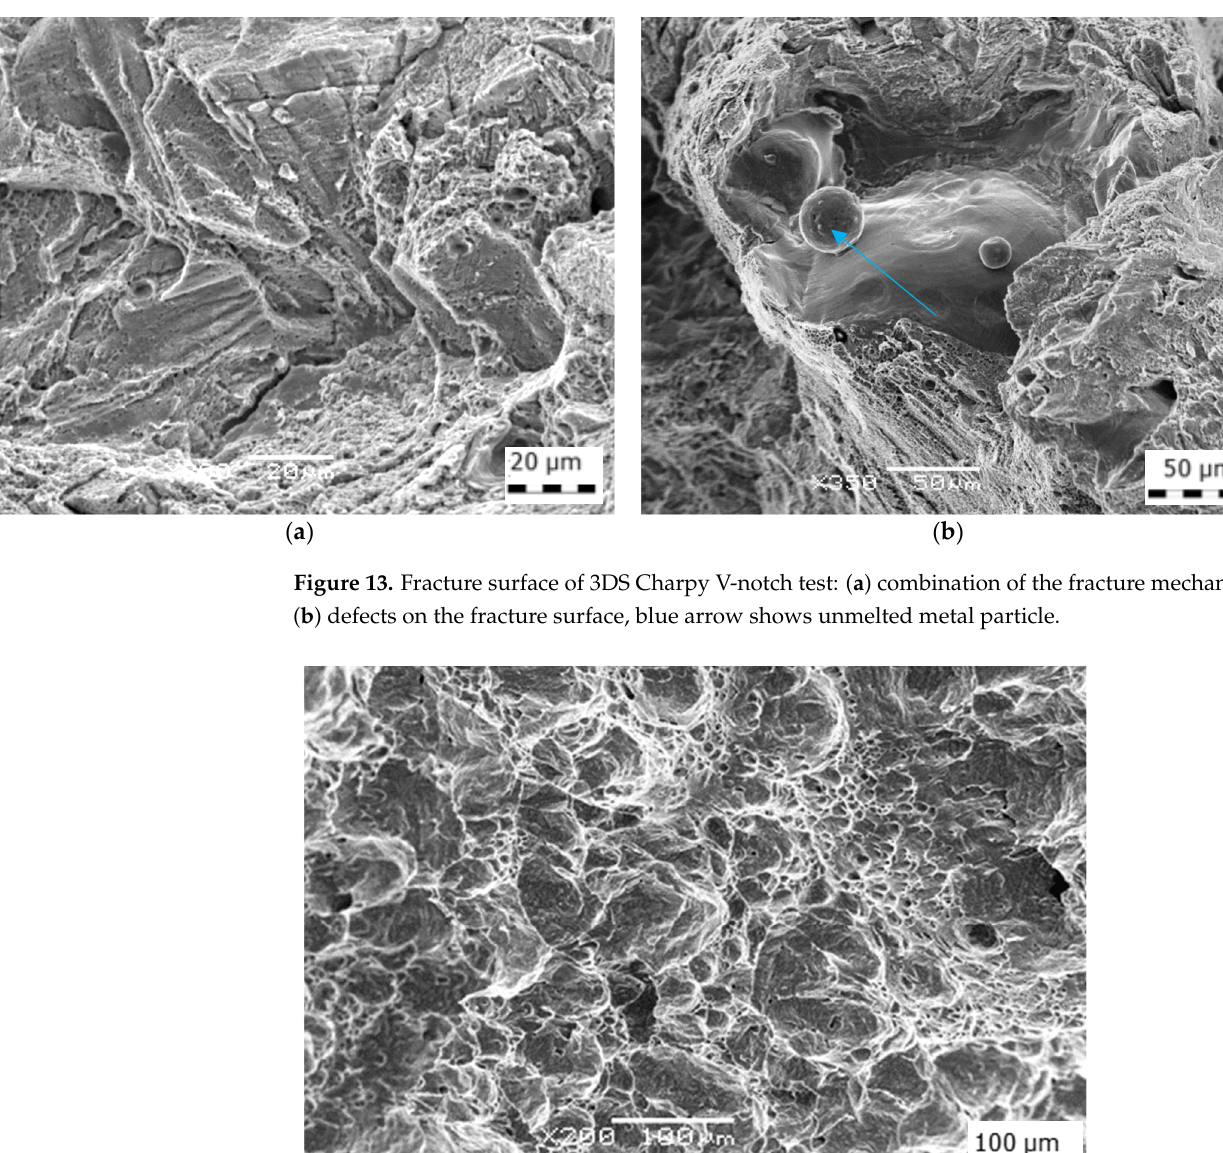
Figure 12. Fracture surface of 3D Charpy V-notch test: ( a ) transgranular fracture; ( b ) defects on the fracture surface, blue arrow shows unmelted metal particles.